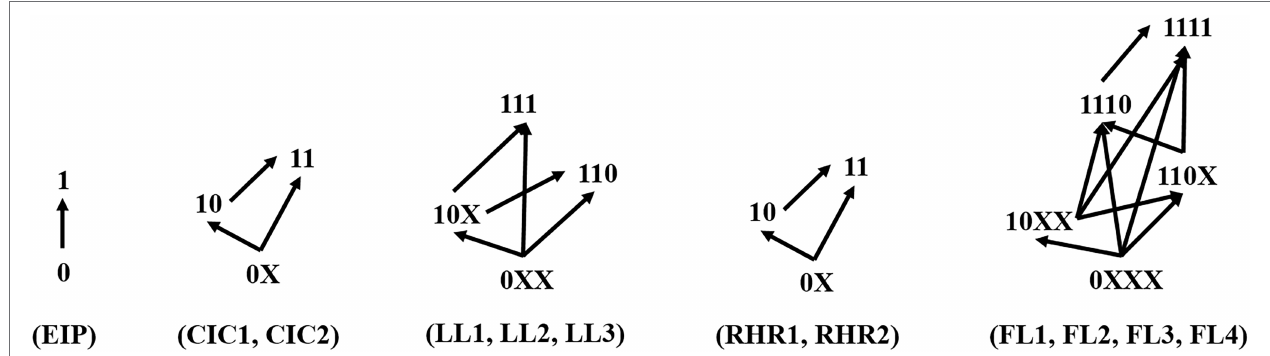
FIGURE 4 | Classification schemes and learning paths based on attribute mastery pattern. The 12 attributes are divided into five groups according to the knowledge content. Students are categorized by their mastery pattern for each attribute group. 1 represents mastered the attribute, 0 represents not mastered the attribute, and X represents 1 or 0. The arrow represents the learning path after diagnosis and classification, the tail of the arrow represents the attribute mastery pattern of the pre-test, and the tip refers to the target attribute mastery pattern after the layered remedial